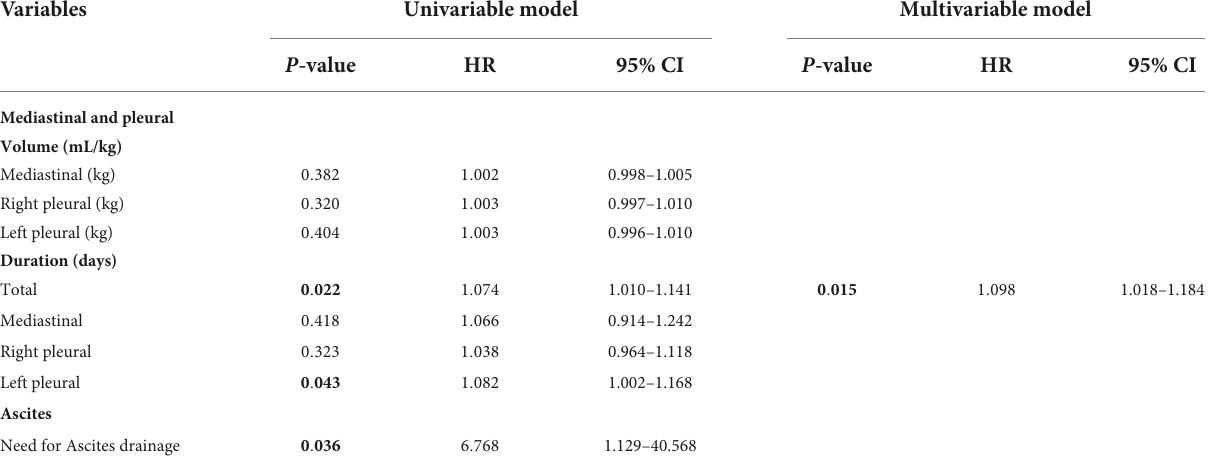
TABLE 5 Factors associated with adverse events after total cavopulmonary connection